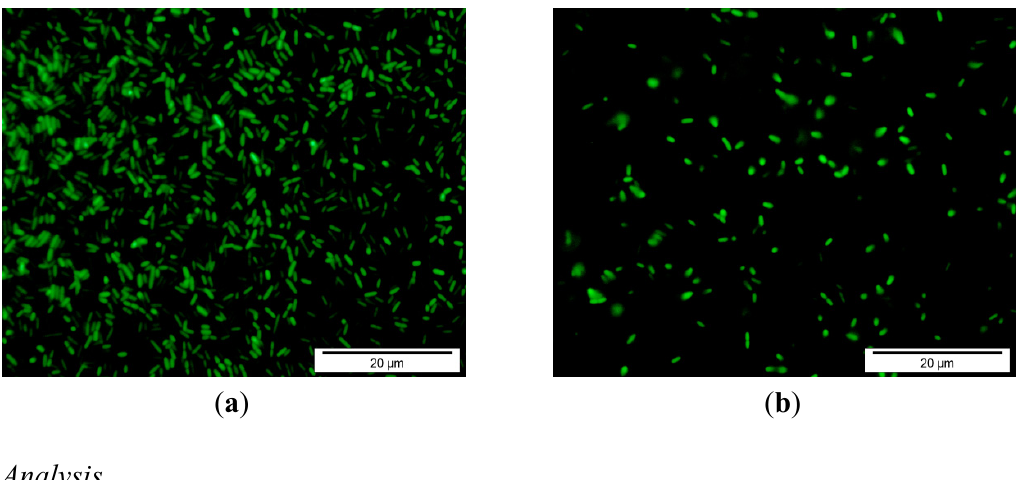
Figure 2. Examples of fluorescence images of the EDG-e strain of Listeria monocytogenes attached to unmodified ( a ) and modified ( b ) PES surfaces using static conditions.